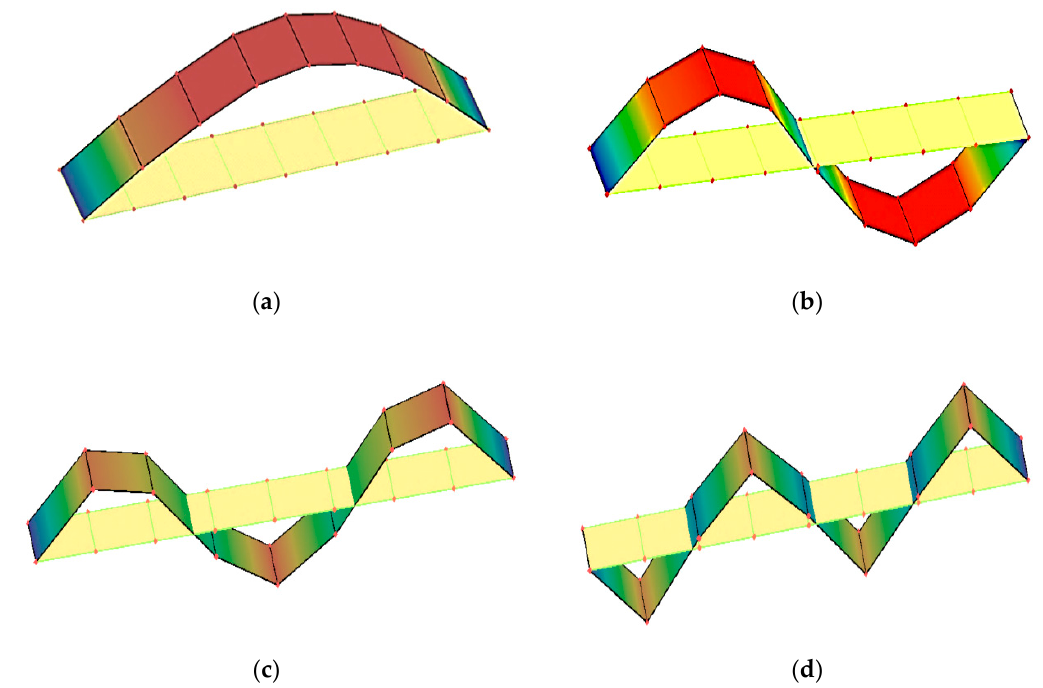
Figure 6. First four-order mode shapes. ( a ) 1st mode. ( b ) 2nd mode. ( c ) 3rd mode. ( d ) 4th mode.